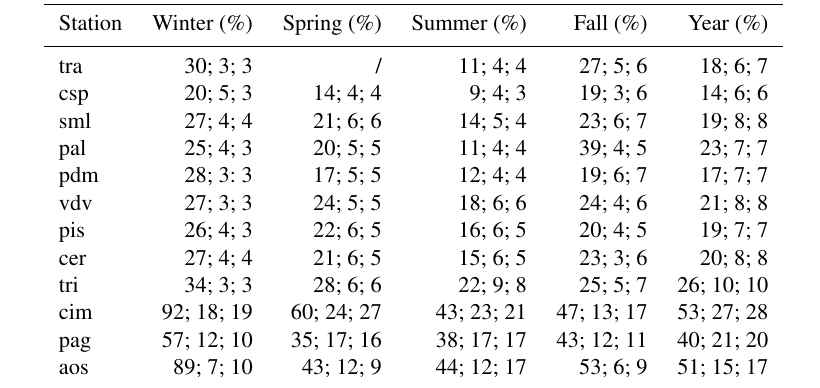
Table 4. rRMSE (%) for the MSG-GHI estimate computed for hourly and daily integrated GHI for different seasons and stations. The first number in each cell is the rRMSE computed using hourly data, the second number is the rRMSE computed for daily integrated GHI, and the third number is the rRMSE computed after the MOS correction for daily integrated GHI (see text for details).